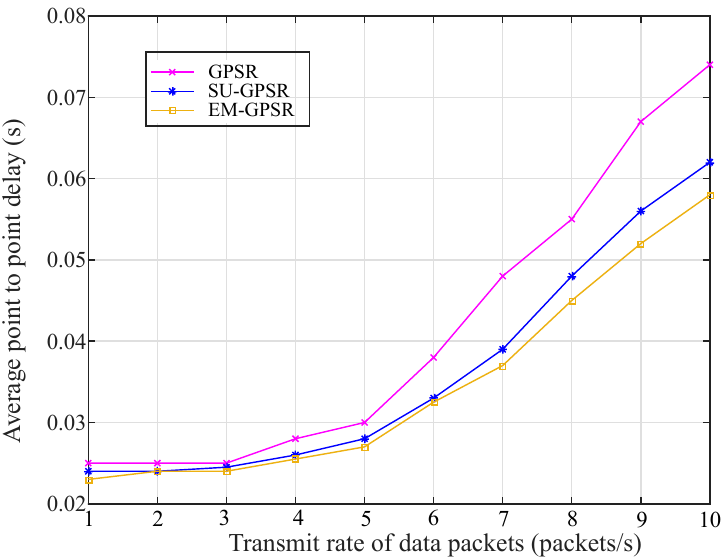
Figure 12. Average end-to-end delay versus transmit rate of data